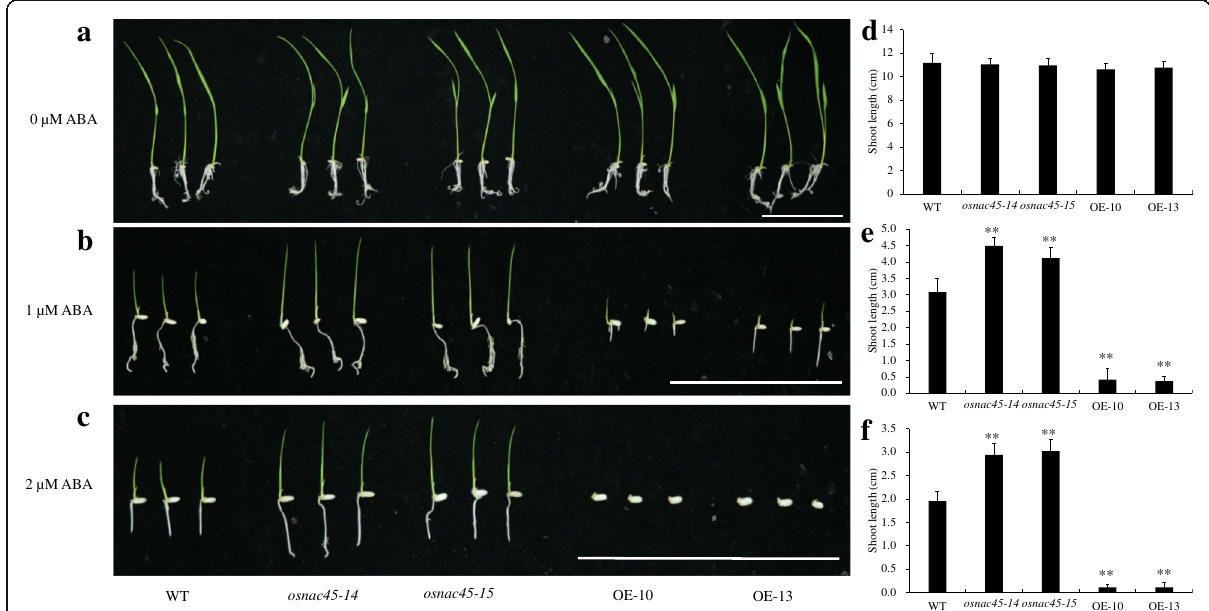
Fig. 4 Early growth of OsNAC45 -knockout ( osnac45 – 14 , osnac45 – 15 ) and OsNAC45 -overexpression (OE-10, OE-13) line seedlings under different concentrations of ABA. Performance of Nipponbare, osnac45 and OE seedlings 5 days after being transferred to 1/2-strength MS medium containing 0 μ M ABA ( a ), 1 μ M ABA ( b ), 2 μ M ABA ( c ). All seeds were germinated on 1/2-strength MS medium without ABA for 2 days before the ABA treatment. Scale bar = 10 cm. d Shoot length of Nipponbare, osnac45 and OE seedlings after 5 days on 1/2-strength MS medium containing 0 μ M ABA ( d ), 1 μ M ABA ( e ), 2 μ M ABA ( f ). The data represent the means ± SD ( n ≥ 10 each), ** P < 0.01 by the Student ’ s t